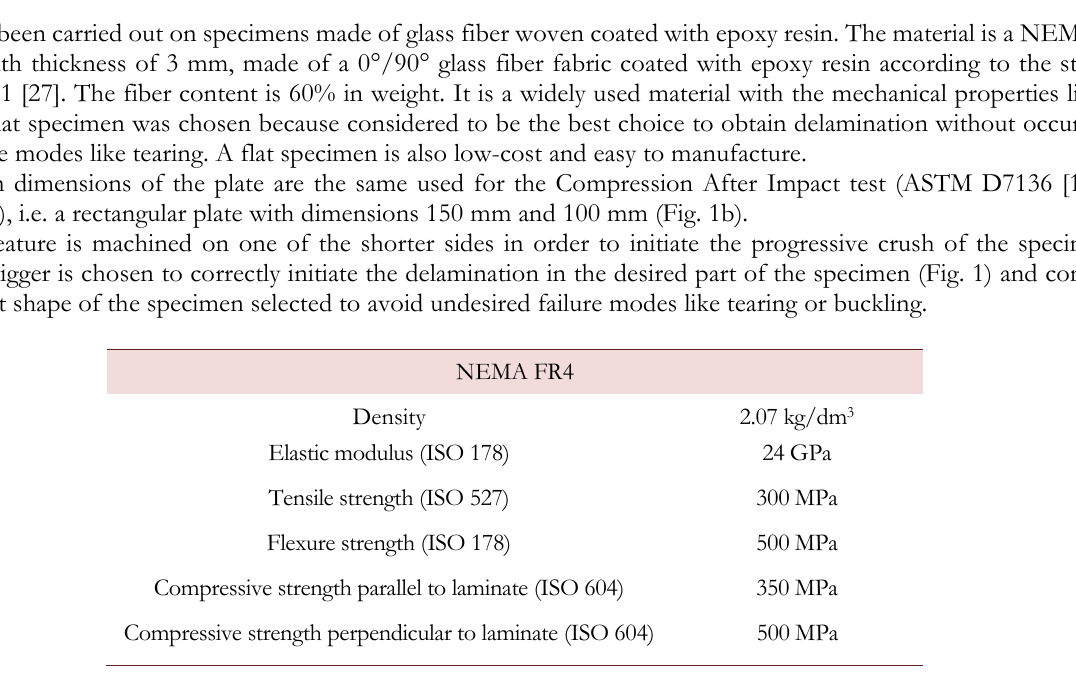
Table 1: Mechanical properties of NEMA FR4 laminates. The density was measured by the authors, while the other properties are given by the supplier of the material